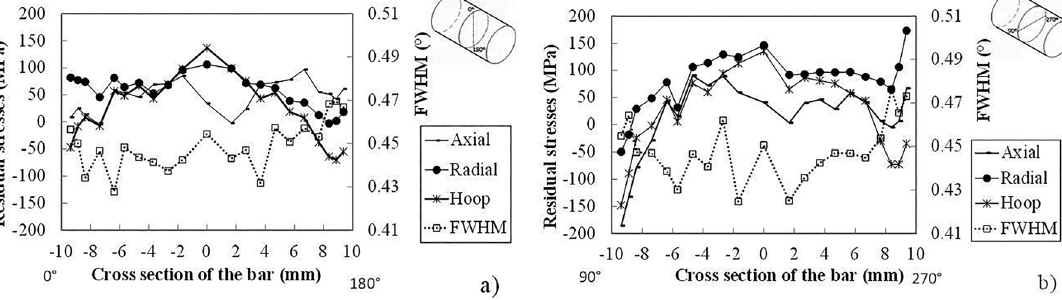
Figure 13. Residual stresses and FWHM in the sections (a) 0°-180° and (b) 90°-270° by neutron diffraction after the vertical pre- straightening process in the bar cross sections.